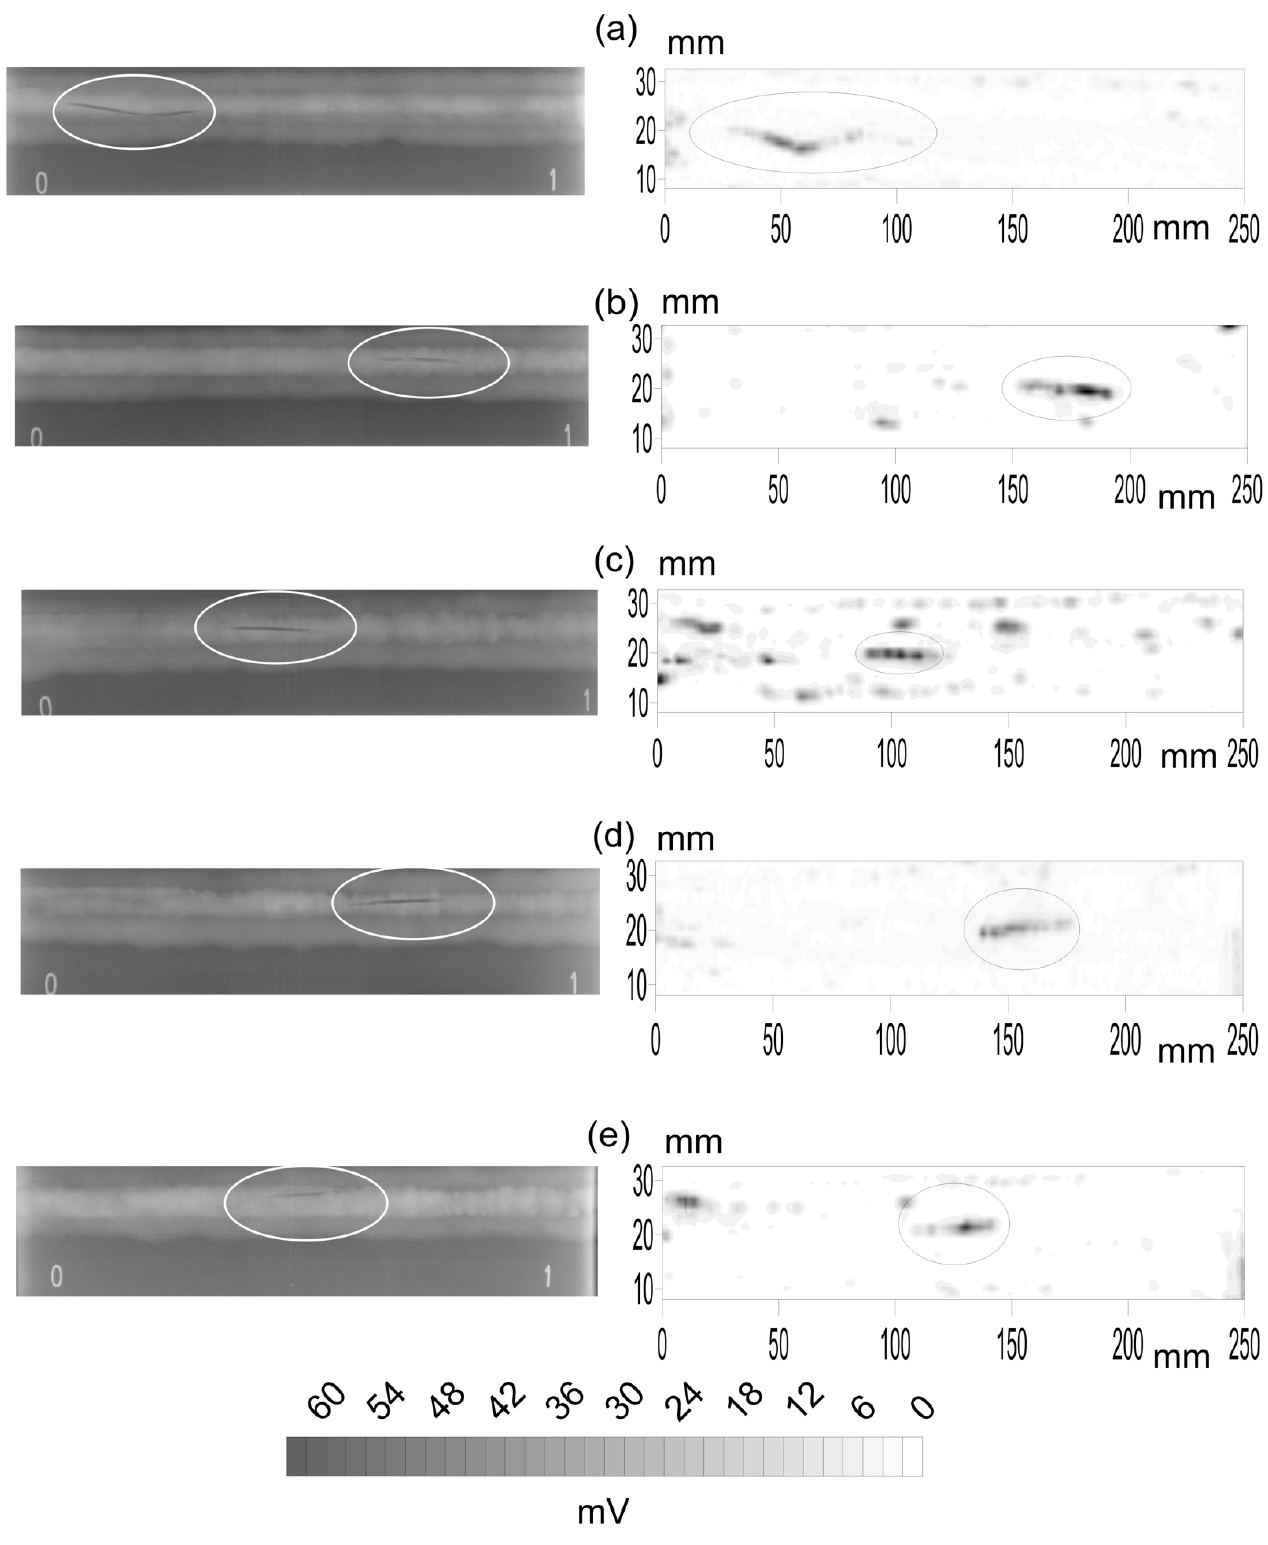
Figure 6. X-ray ( left ) and phased array inspection ( right ) of five specimens, ( a – e ), with cracks. The length of the specimen is 250 mm and their width is 30 mm with the axis of the weldment in the middle. The small numbers 0 and 1 in the X-rays images were added when inspected.